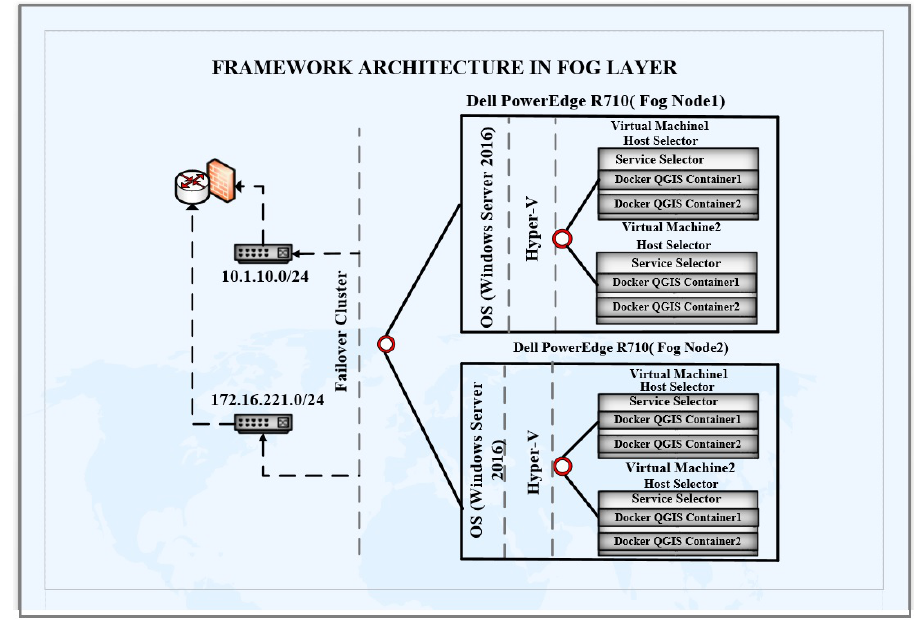
Figure 4. Architecture of fog layer.